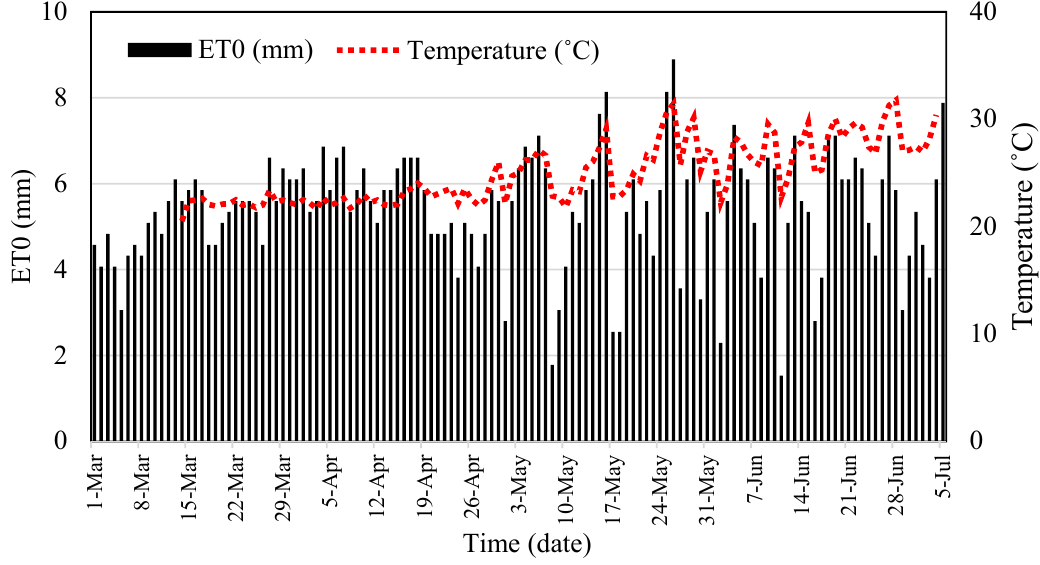
Figure 2. Measured daily average air temperature (°C) and reference evapotranspiration (ET 0 ) in greenhouse-controlled environment during the soybean growing season.